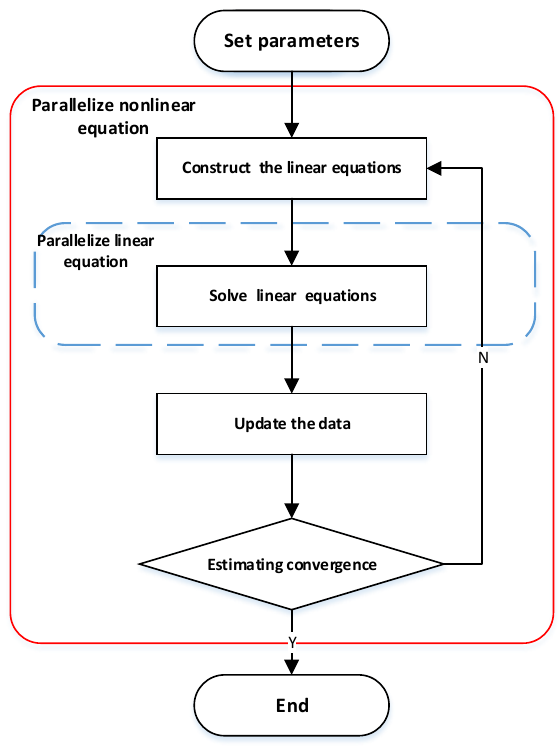
Figure 2. Two parallel idea